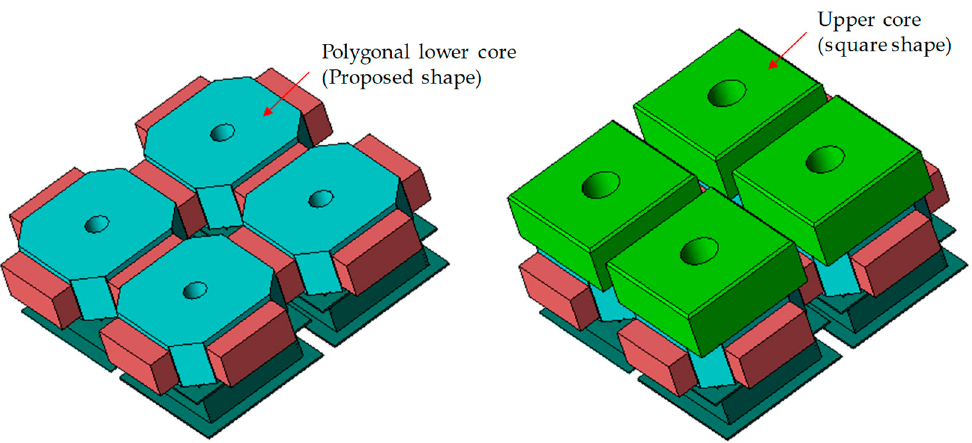
Figure 13. Model showing the polygonal structure applied to the lower core.